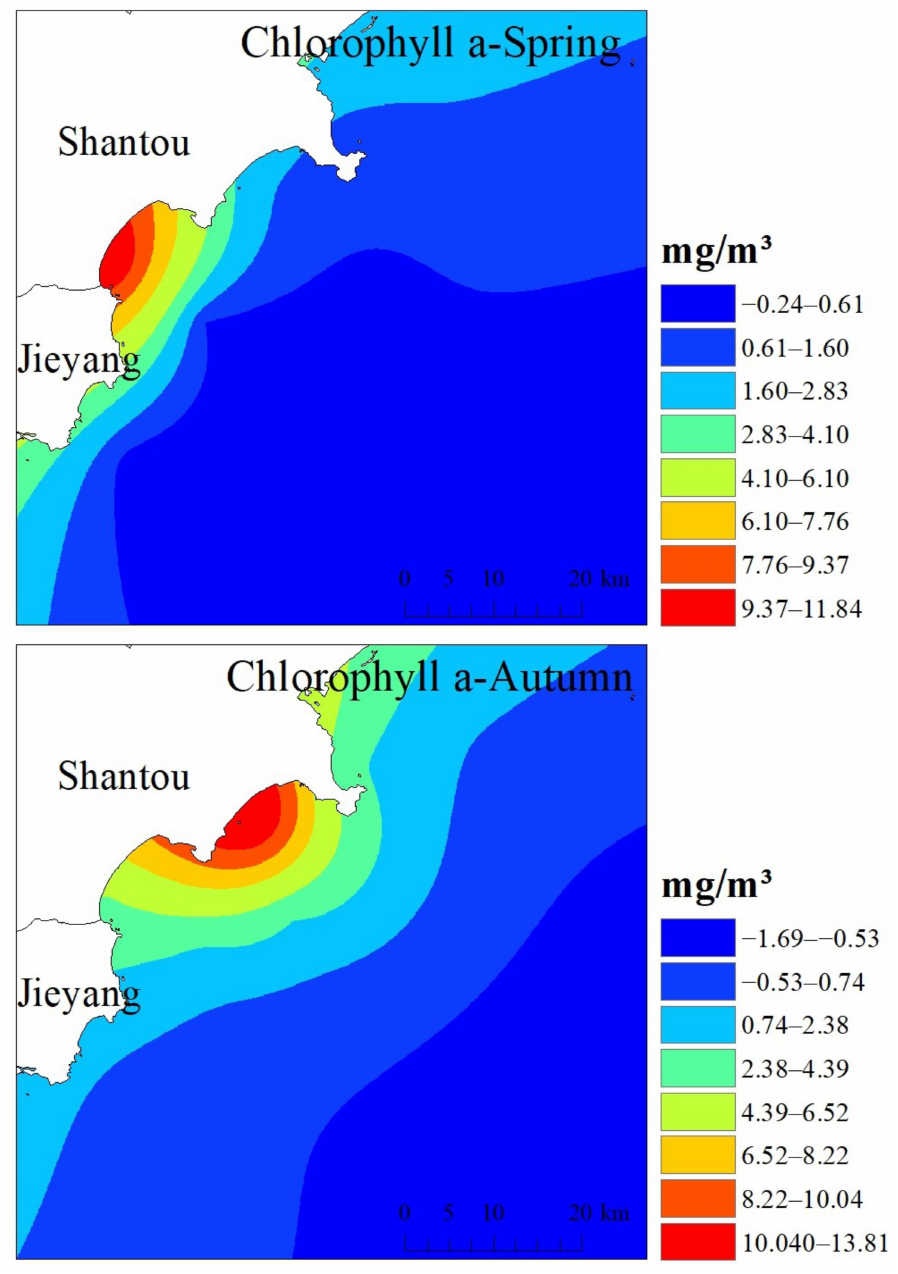
Figure 3. Results of chlorophyll a in coastal